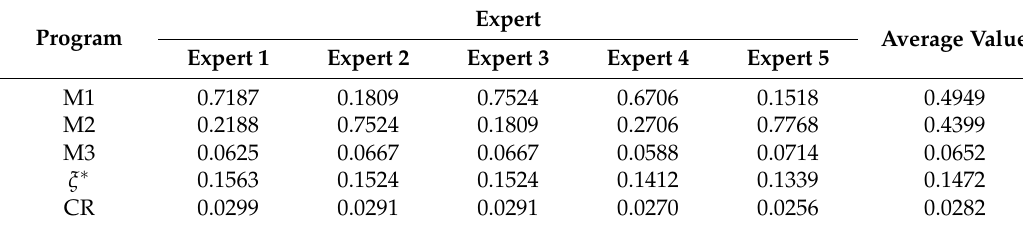
Table 6. Performance values of three micro-grid planning programs of safety of energy storage